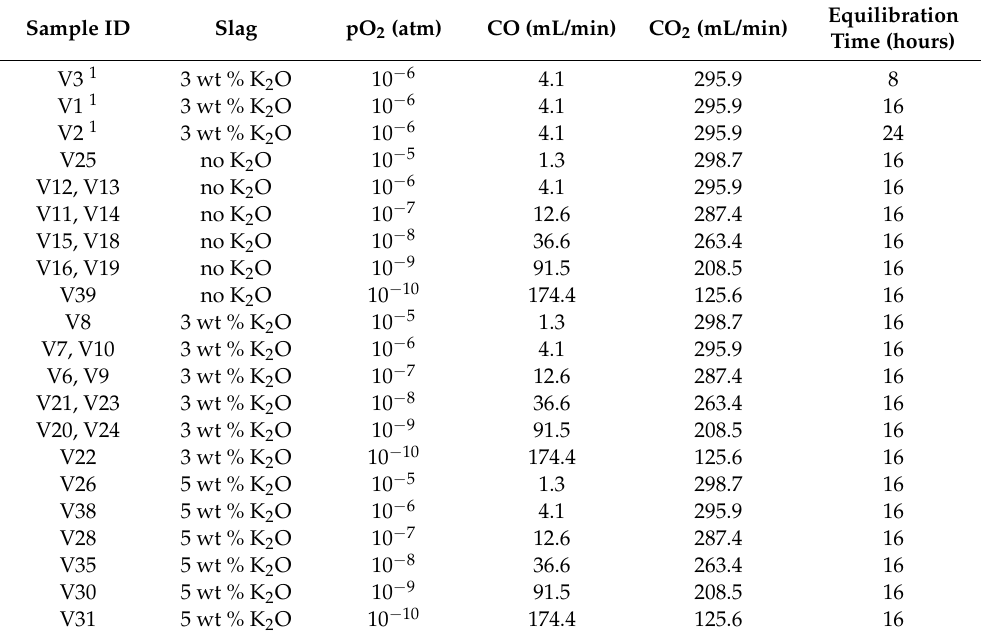
Table A1. List of experiments and experimental conditions. Temperature was kept constant at 1300 ◦ C.